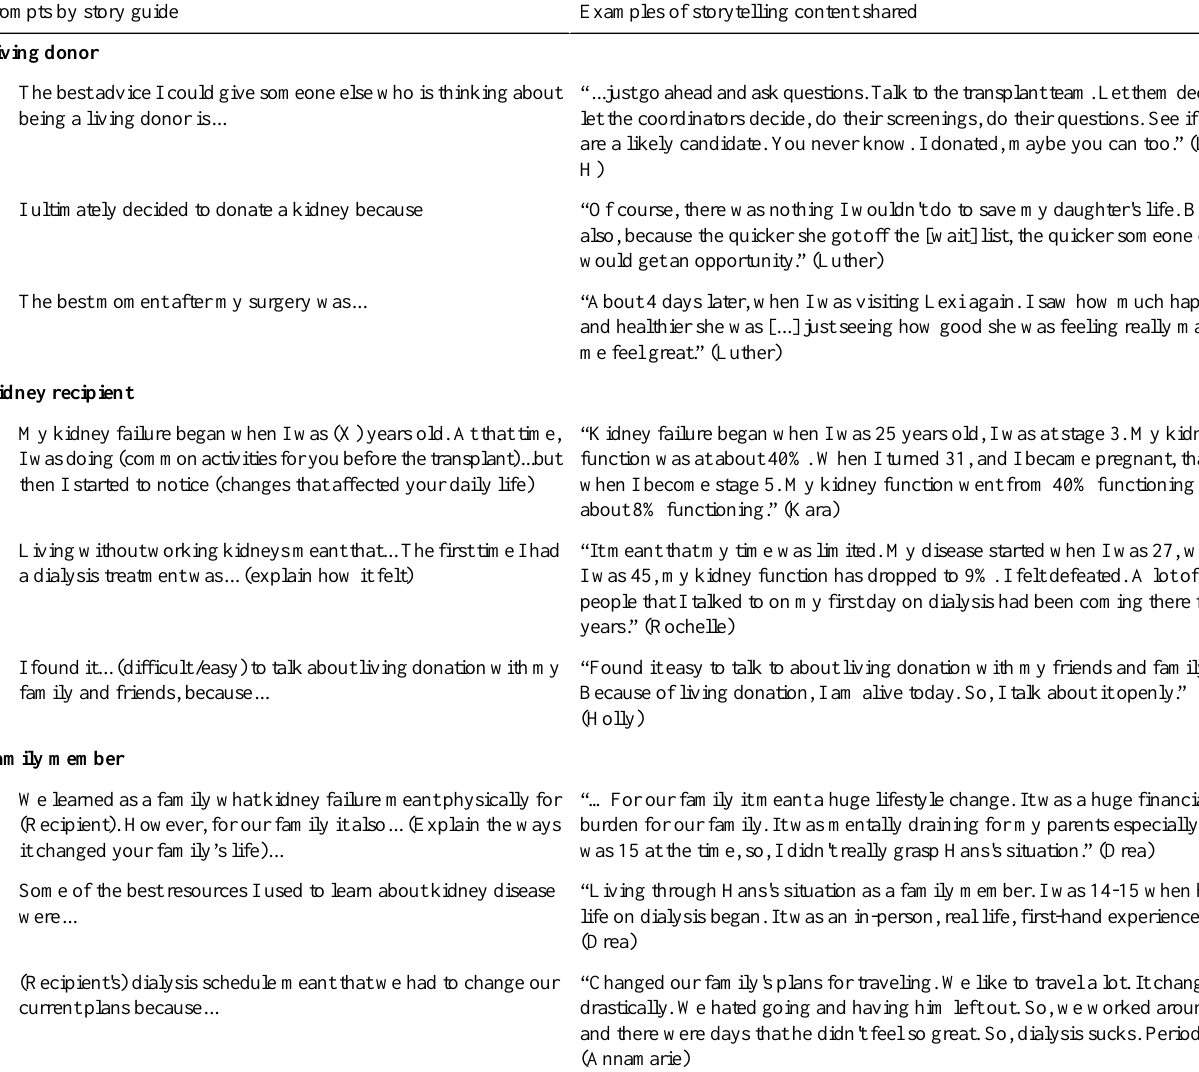
Table 3. Content shared by donors, recipients, and family around open-ended